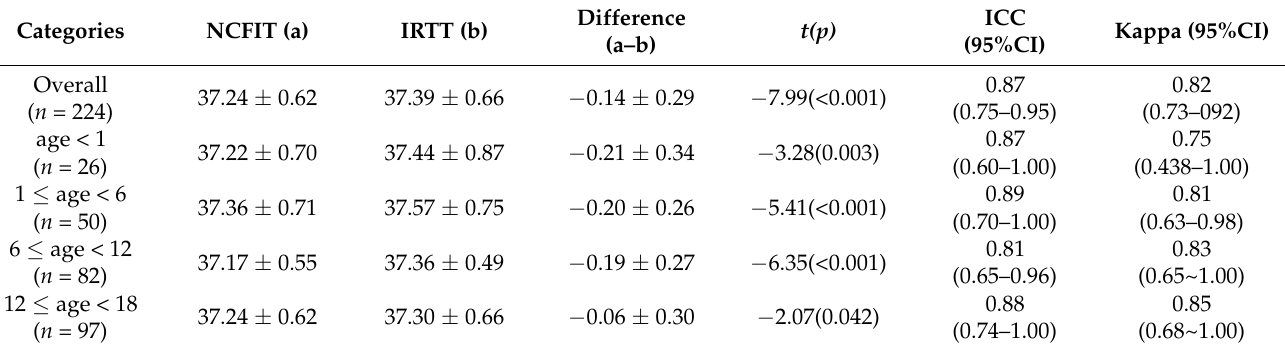
Table 2. Comparison of tympanic temperatures and non-contact infrared temperatures by age group.